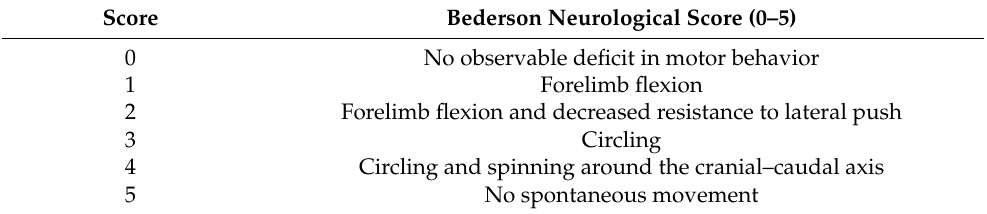
Table 2. Bederson neurological score